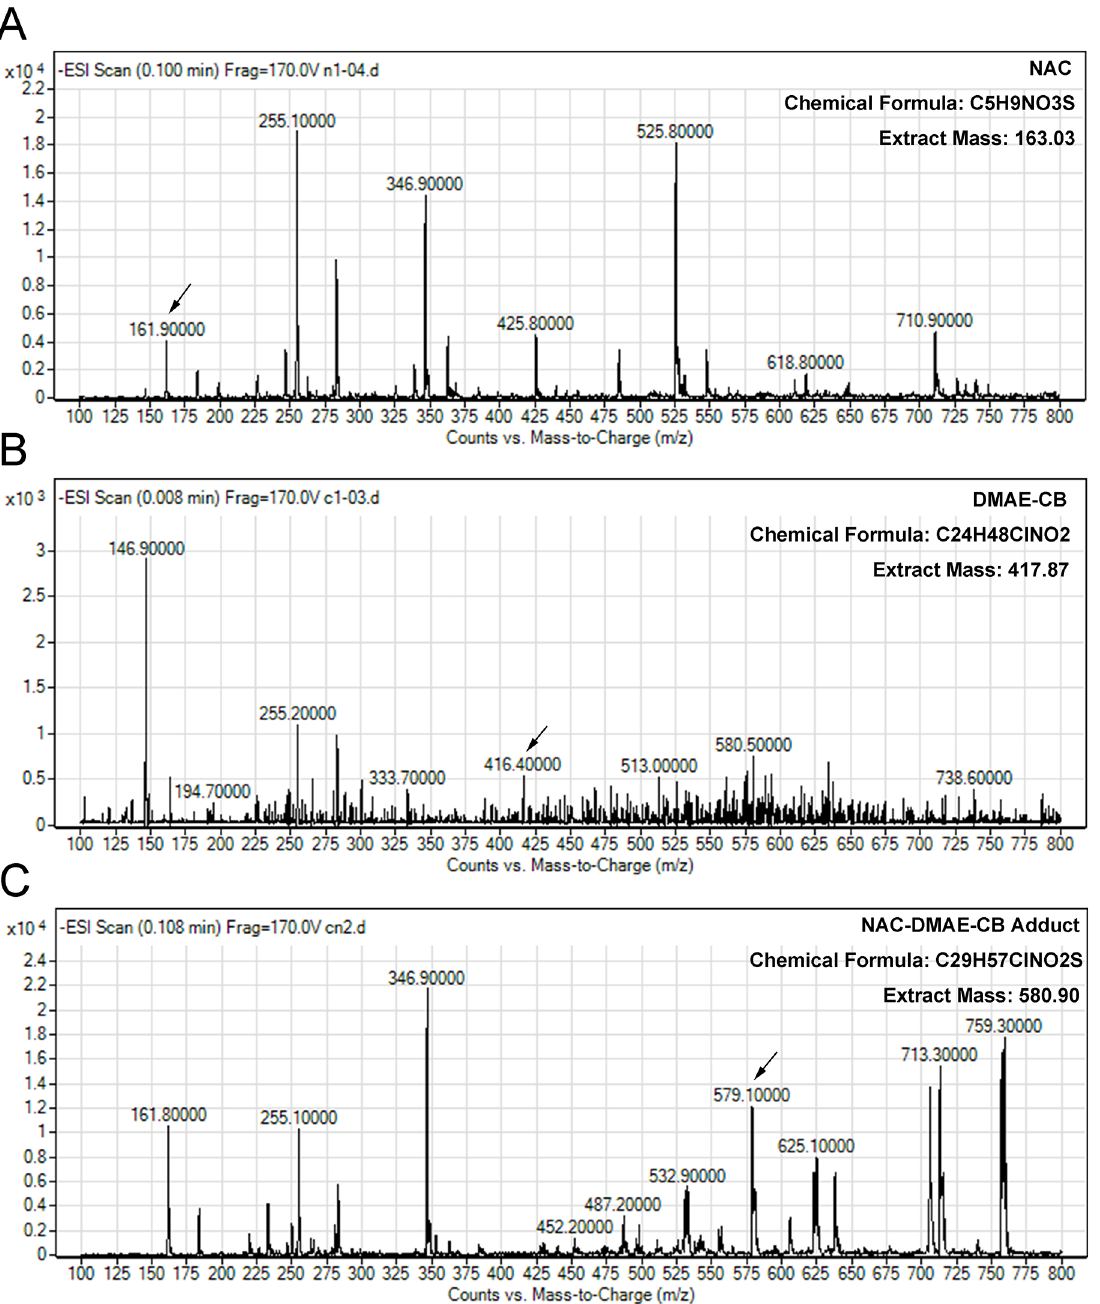
Fig 2. Detection of NAC-DMAE-CB adduct by LC-MS after 48 h of incubation. A, B and C shows the full scan MS spectra of NAC (m/z = 161.9, [M-H]), DMAE-CB adduct (m/z = 416.7, [M-H]) and NAC-DMAE-CB, respectively adduct (m/z = 579.1, [M-H]). Arrows indicate the peak of the three